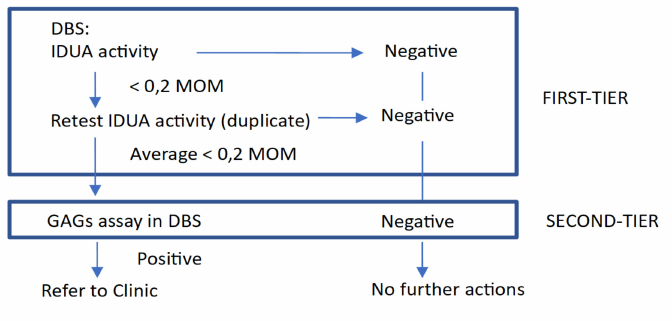
Figure1. Two-tierNewbornScreeningAlgorithmforMPSI.DBS:driedblootspot, IDUA: α -L-iduronidase, MOM: multiple of median, GAGs: glycosaminoglycans (dermatan sulfate, heparan sulfate).